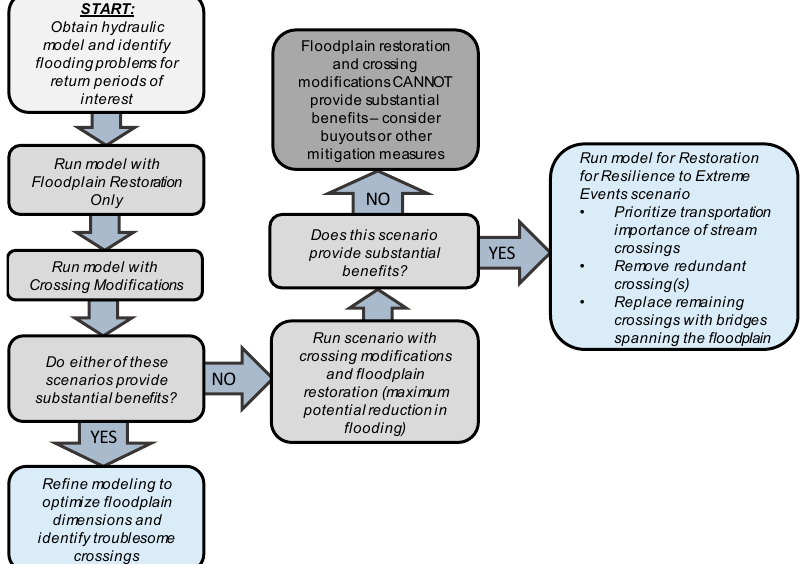
Figure13. Flowdiagramillustratingtheproposedplanningframeworkforevaluatingstreamrestoration Figure 13. Flow diagram illustrating the proposed planning framework for evaluating stream projects for the potential to provide resilience to extreme restoration projects for the potential to provide resilience to extreme events.